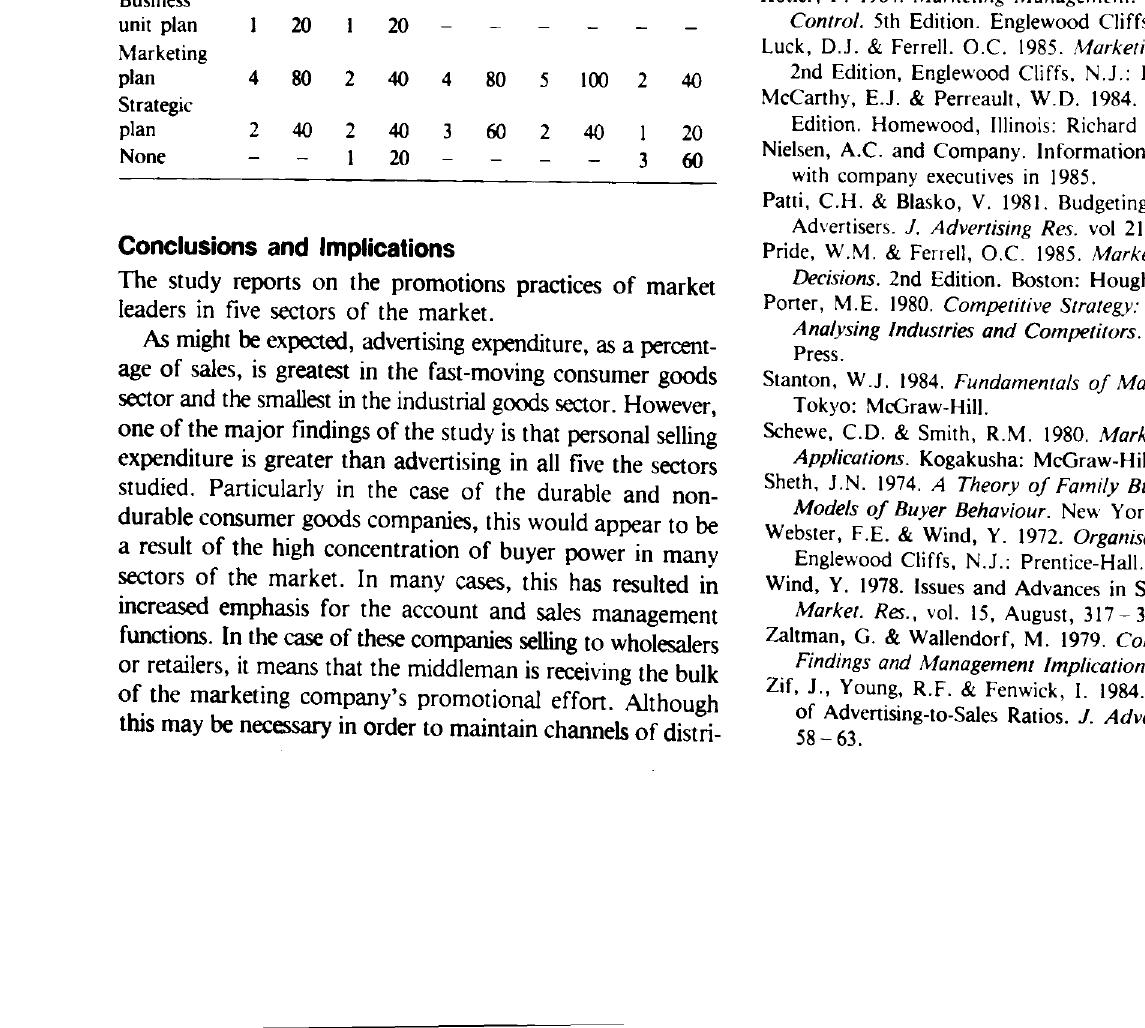
Method of co-ordinating elements of